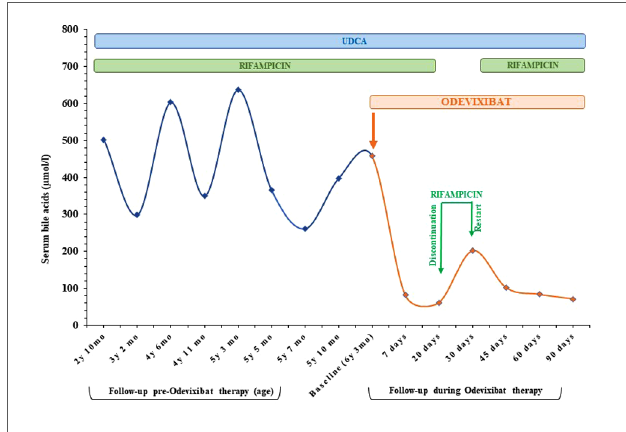
FIGURE 1 Serum bile acids in response to therapies. The start of Odevixibat therapy (orange arrow) coincides with a considerable reduction in serum bile acids compared to when the patient was treated only with UDCA (25 mg/kg/ day) and rifampicin (5 mg/kg/day). mo, months; UDCA, ursodeoxycholic acid; Y,